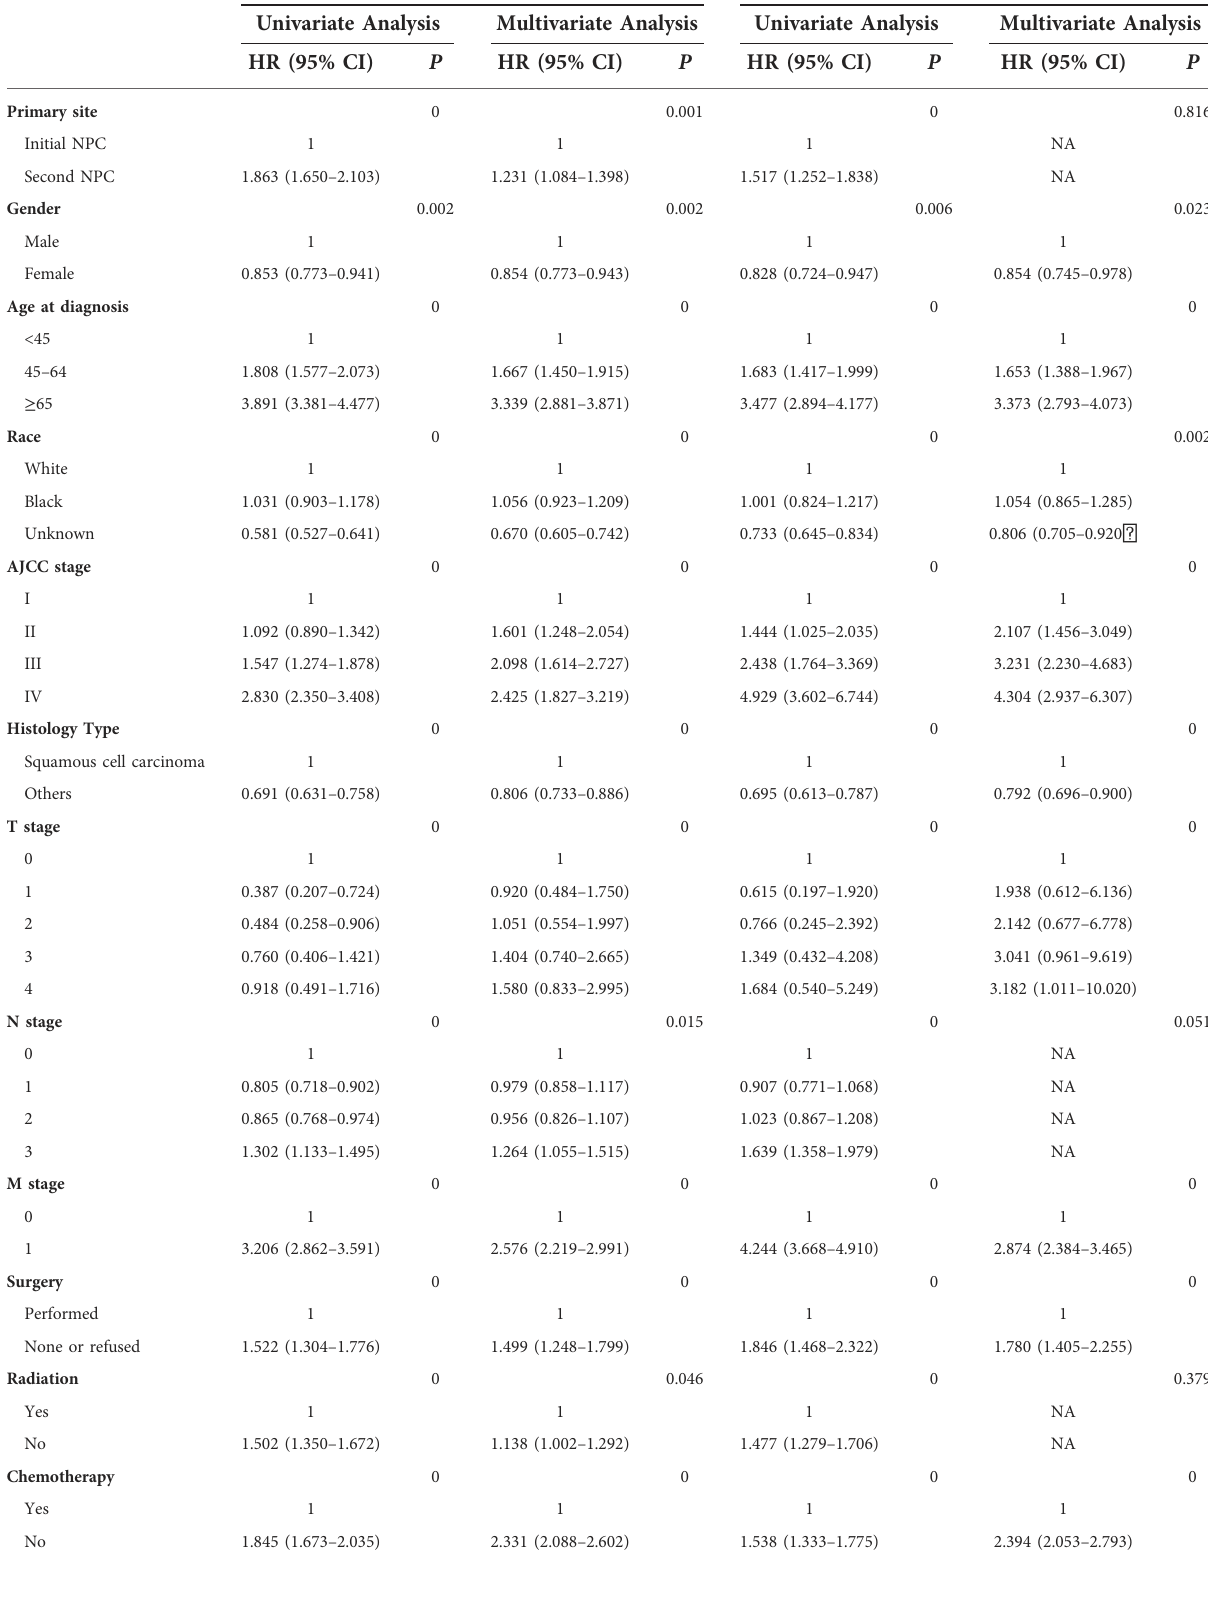
TABLE 3 Univariate and multivariate analysis for evaluating prognosis factors on